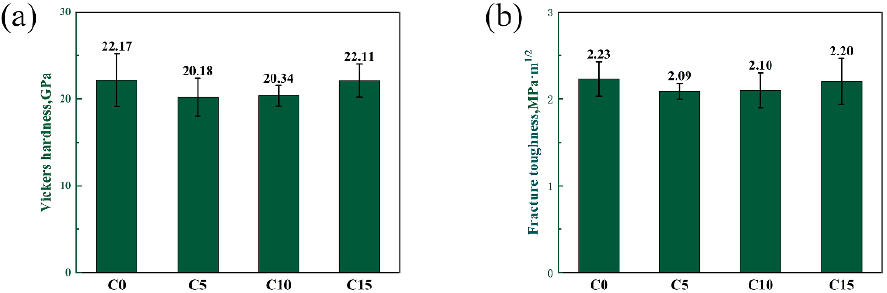
Figure 11. ( a ) Vickers hardness and ( b ) fracture toughness of composites with different carbon con- tents.